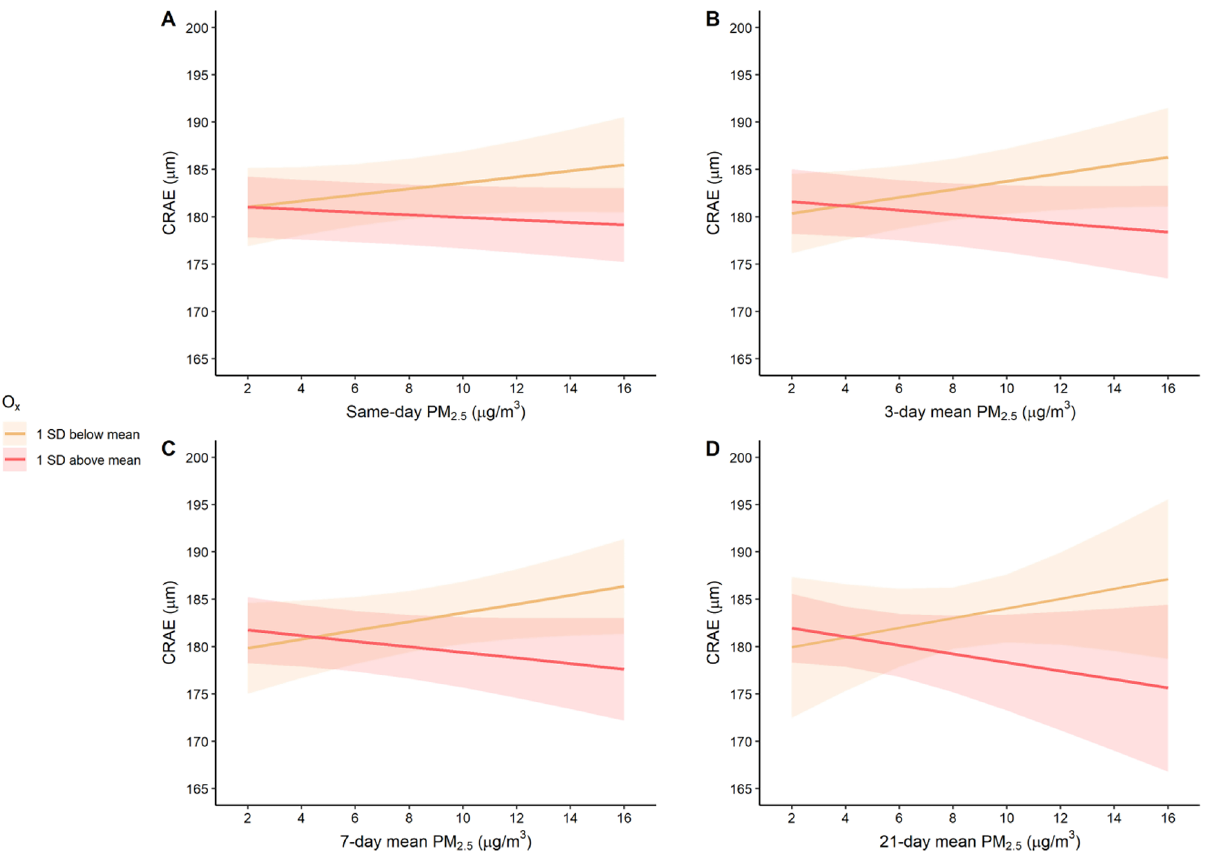
Figure 3. Predicted values and 95% confidence intervals for central retinal arteriolar equivalent (CRAE) at different concentrations of PM 2.5 , stratified by O x (1 standard deviation below and above mean O x ). Plots correspond to ( A ): Same-day exposure lag; ( B ): 3-day mean exposure lag; ( C ): 7-day mean exposure lag; ( D ): 21-day mean exposure